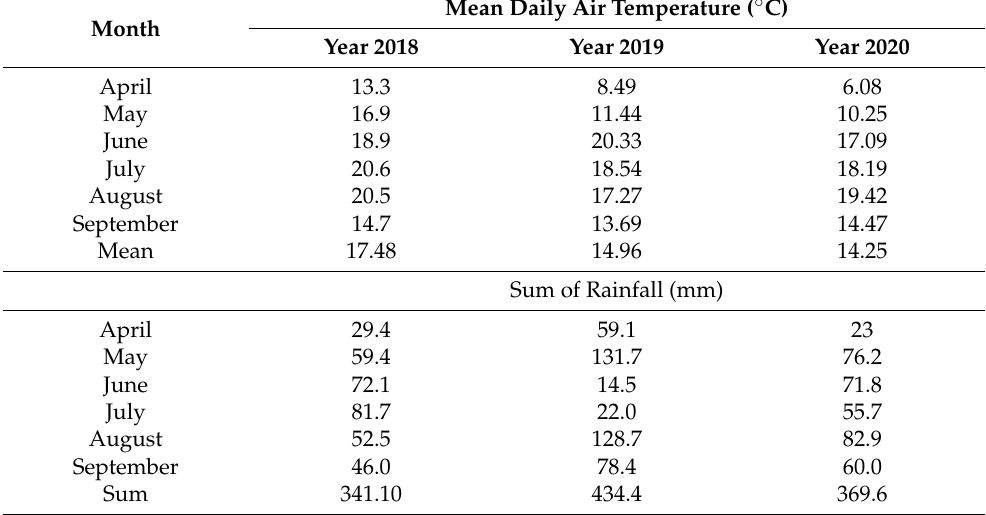
Table 8. Meteorogical data